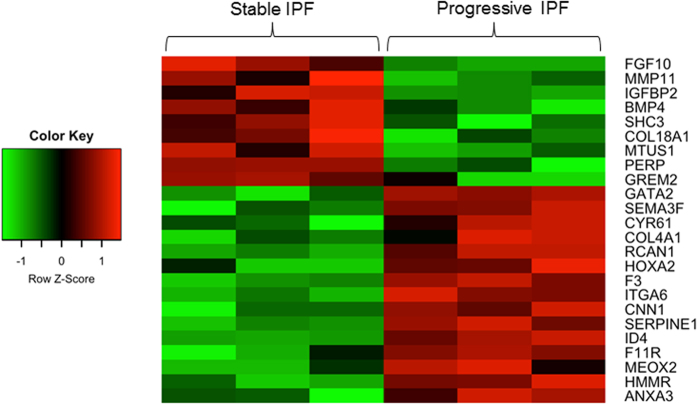
Heat map analysis of lung developmental genes.Heat map representing color coded expression levels of differentially expressed genes in progressive IPF compared to stable IPF (n = 3 in each group; p < 0.005). Up-regulated genes were shown in shades of red whereas down-regulated genes were shown in shades of green.